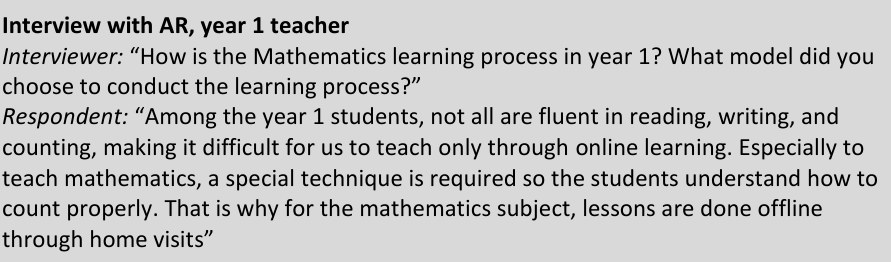
Table 3. The result of interviews with the